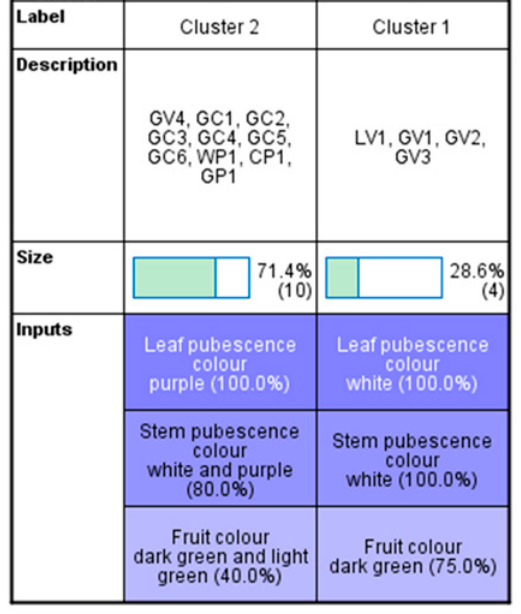
Fig. 4: Two-step cluster analysis of fourteen accessions of Solanum anguivi Lam. based on their morphological